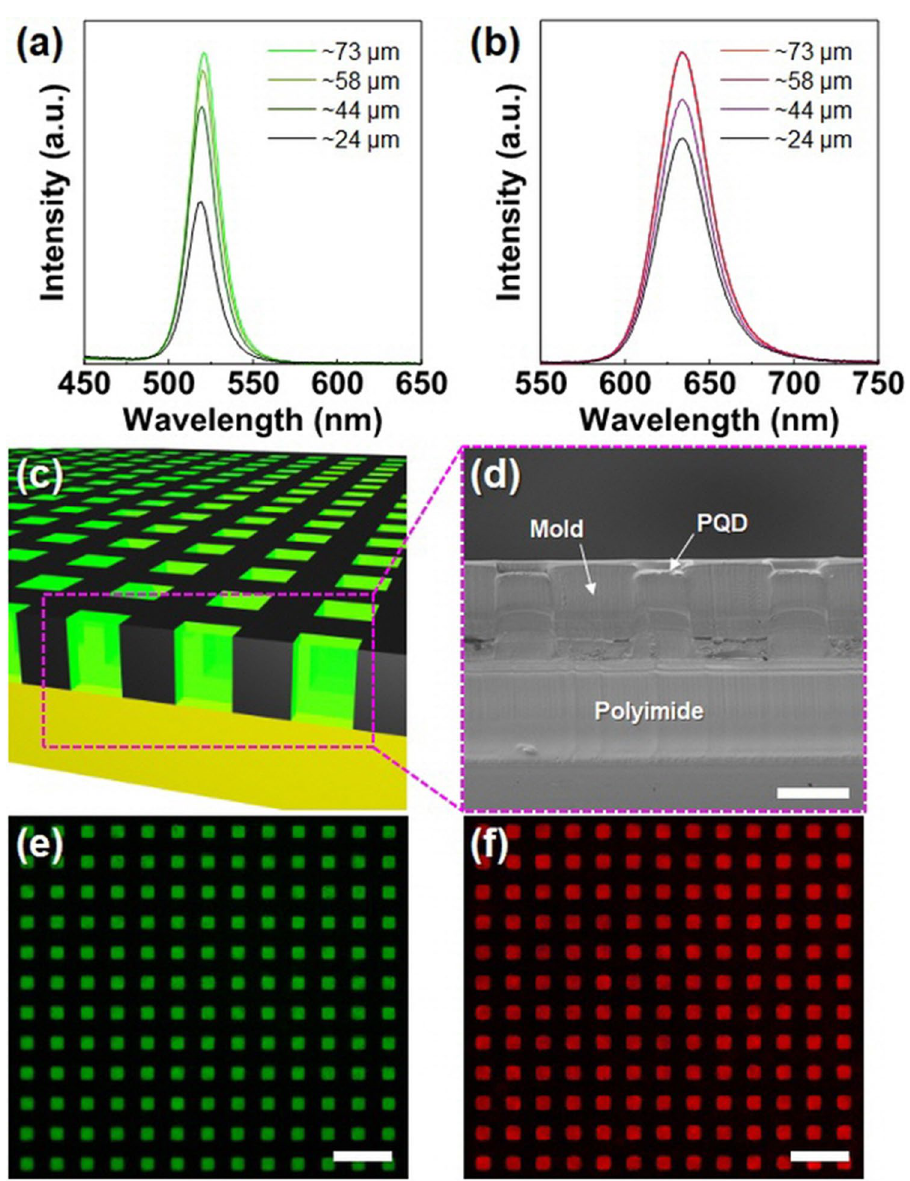
Figure 4. Photoluminescence spectra (PL) of ( a ) green and ( b ) red perovskite quantum dots (PQDs) with different thicknesses excited by blue LEDs (λ ex = 460 nm). ( c ) Schematic illustration and ( d ) cross-sectional scanning electron microscopy image of photopatterned PQD/siloxane composite array filled with a black mold matrix (scale bar: 30 µm). Optical microscope images of photopatterned ( e ) green and ( f ) red PQD/siloxane composite array in a black mold matrix on a substrate, excited by blue LEDs (λ ex = 460 nm) (scale bar: 100